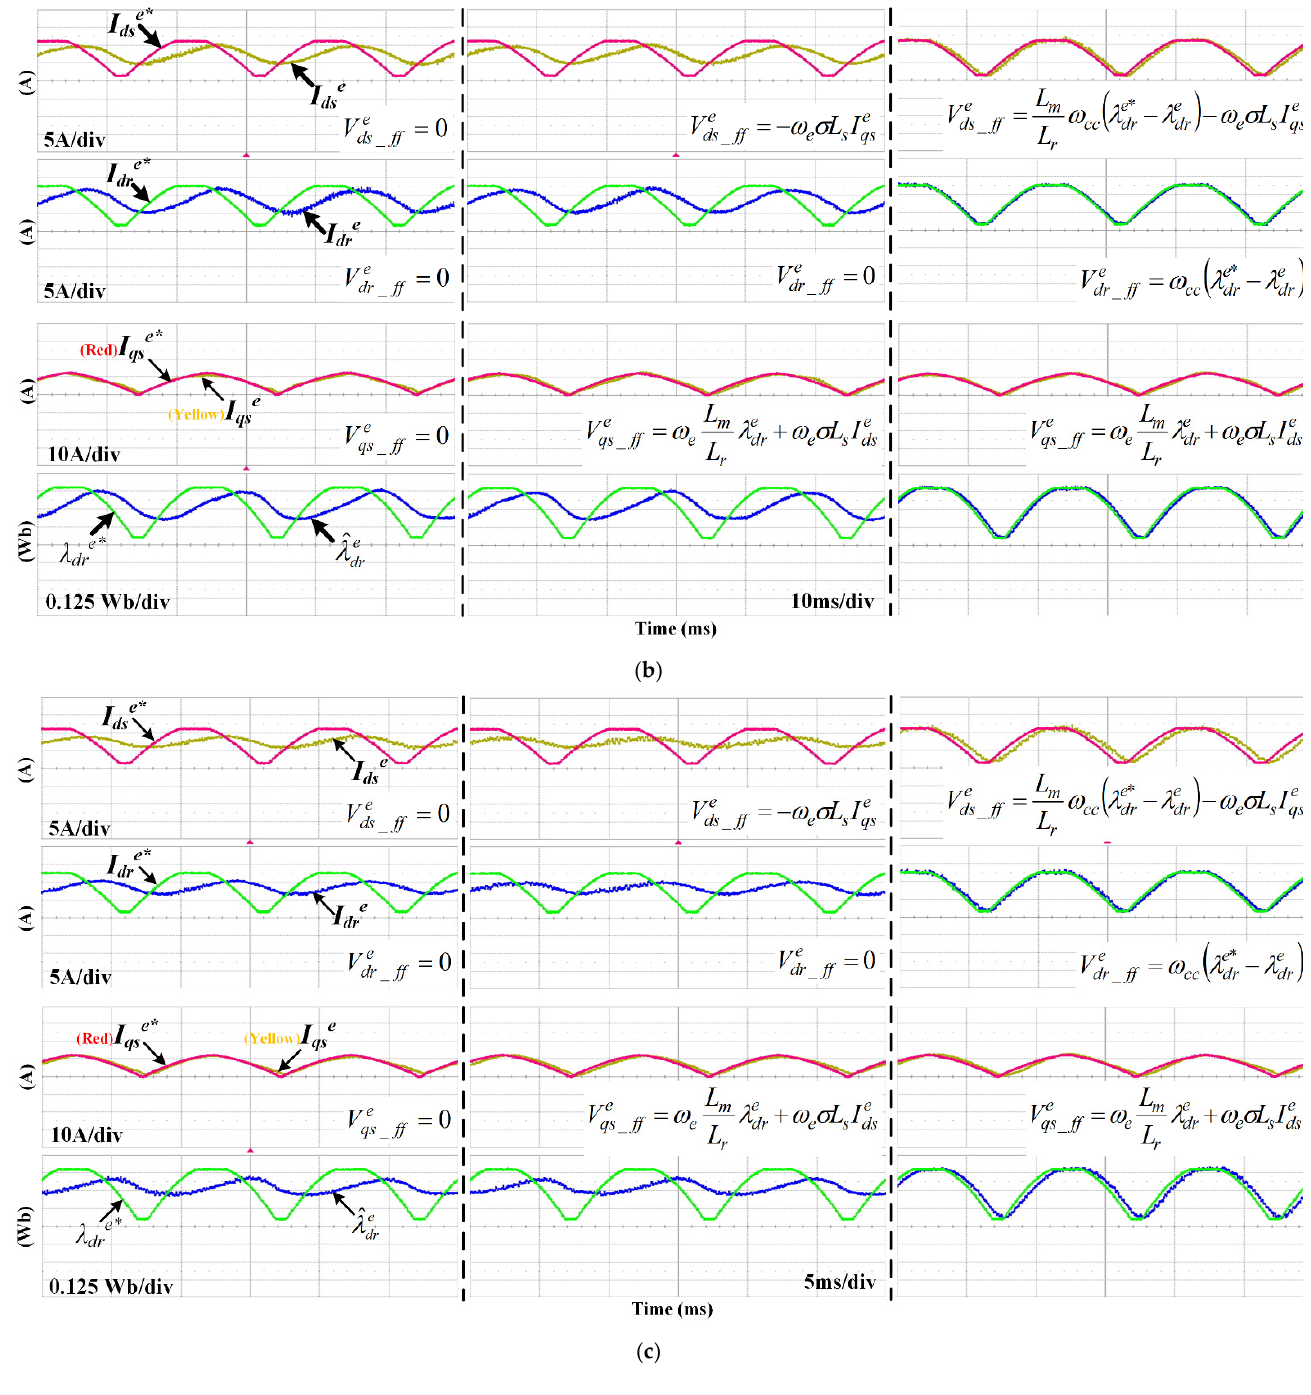
Figure 11. Experimental results of the current, rotor flux, and torque controls of a DIFWM according to sinusoidal torque reference: ( a ) 10 Hz; ( b ) 50 Hz; ( c ) 100 Hz.